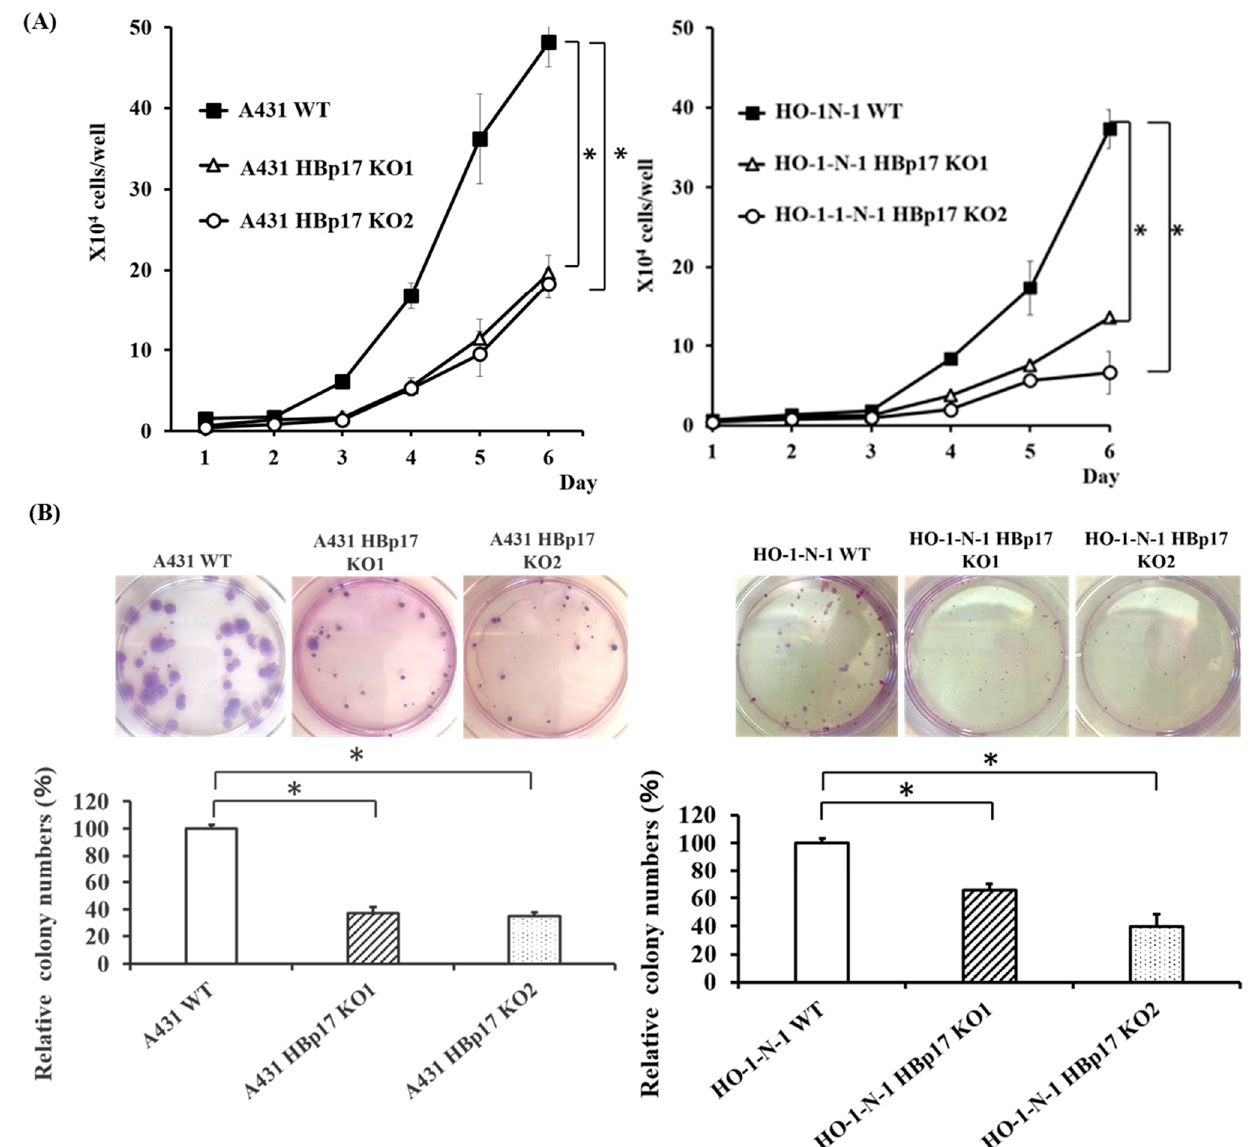
Figure 3. Knockout of HBp17 inhibits cell proliferation and colony formation. ( A ) Cell proliferation and ( B ) colony formation were determined in A431-HBp17-KO1, -KO2, A431-WT, HO-1-N-1-HBp17-KO1, -KO2, and HO-1-N-1-WT cells. Experiments were performed in triplicate with data presented as means + SD. * p < 0.05.